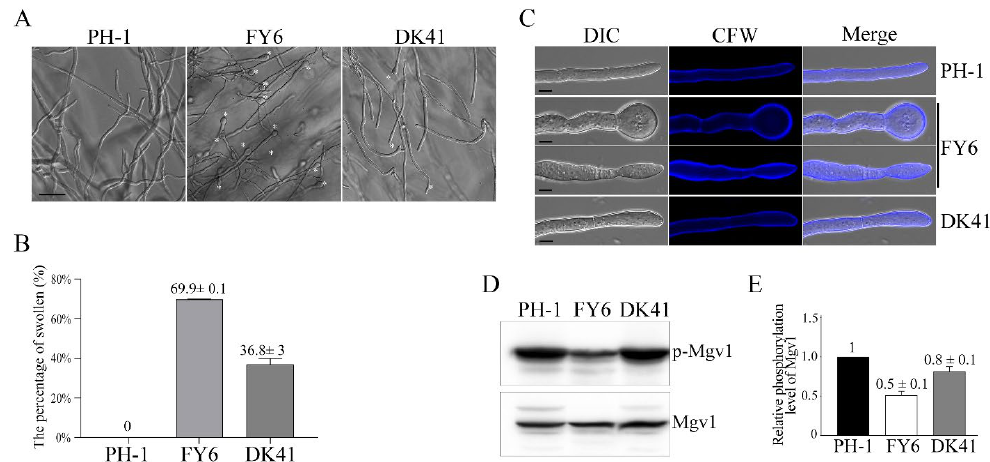
Figure 6. Deletion of FgBNI4 partially suppresses the defects of Fgyck1 mutant in polarized growth and cell wall integrity. ( A ) Hyphae of 36-h-old PDA cultures of the wild type (PH-1) and the Fgyck1 (FY6) and Fgyck1 Fgbni4 (DK41) mutants were examined for swollen tips (marked with asterisks). Bar, 50 µ m. ( B ) The percentage of hyphae with swollen tips in PH-1, FY6, and DK41. ( C ) Hyphae of the marked strains collected from 12 h YEPD cultures were stained with CFW and observed by confocal microscopy. Bar, 5 µ m. ( D ) Total proteins isolated from 18 h vegetative hyphae were used for Western blot analyses with the anti-TpEY and anti-Mgv1 antibodies. ( E ) The relative phosphorylation level of Mgv1 in the Fgyck1 (FY6) and Fgyck1 Fgbni4 (DK41) mutants in comparison with PH-1 (arbitrarily set to 1). The intensities of bands detected on Western blots were analyzed with the Image Lab TM Software 3.0 (Bio-Rad Laboratories, Hercules, CA, USA). For each strain, the phosphorylation level of Mgv1 was estimated by comparing the intensities of the band detected with the anti-TpEY antibody with the band detected with the anti-Mgv1